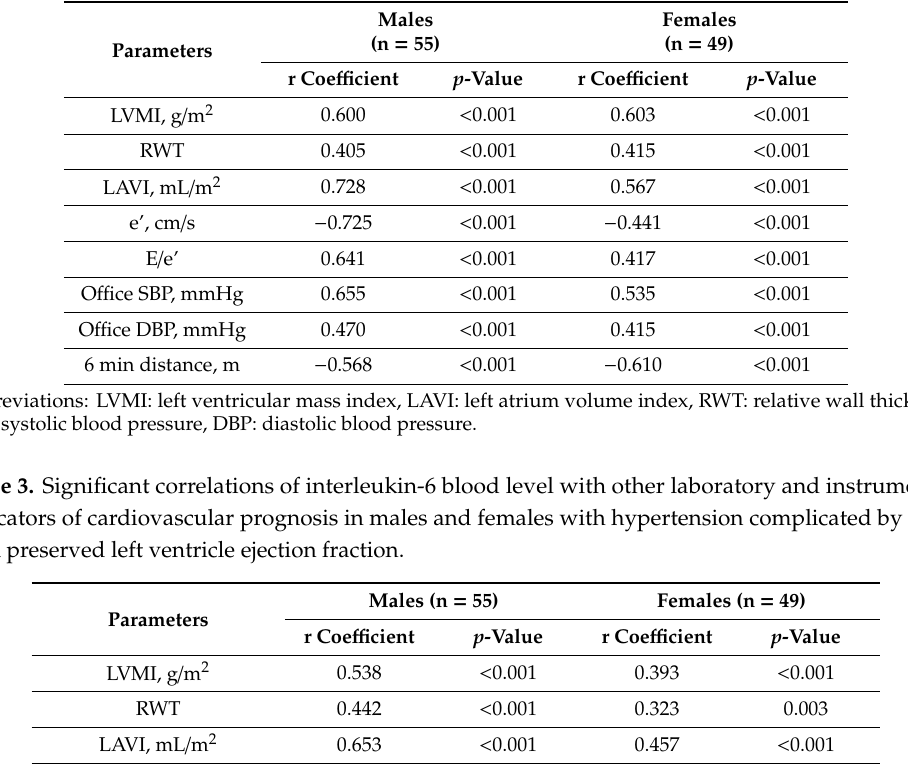
Table 2. Significant correlations of C-reactive blood protein level (mg / L) with other laboratory and instrumental indicators of cardiovascular prognosis in males and females with hypertension, complicated by chronic heart failure with preserved left ventricular ejection fraction.